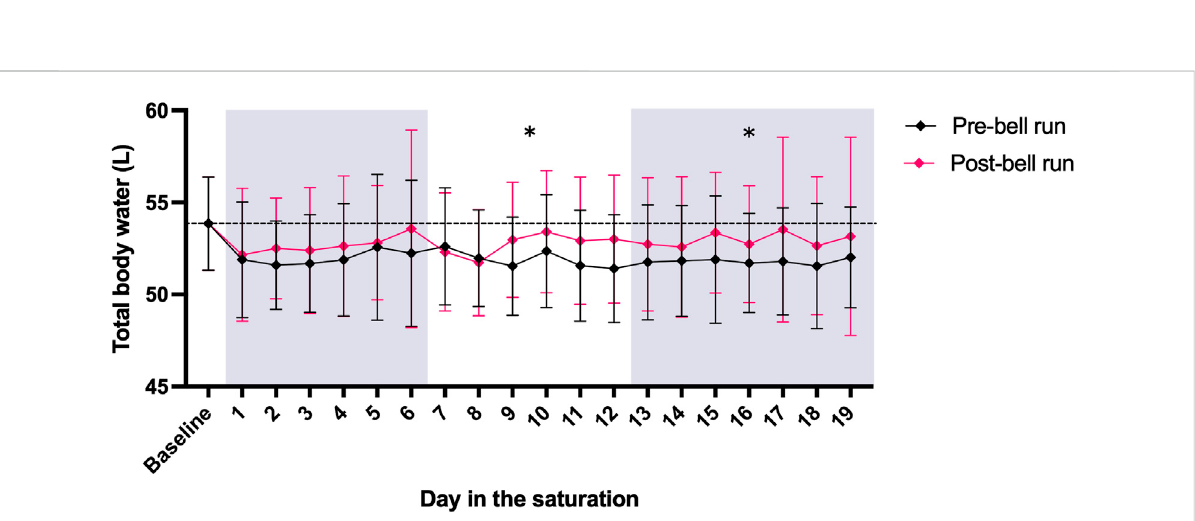
FIGURE 4 TBW calculated from BIA data collected pre- and post-bell runs from 11 saturation divers Diamonds and whiskers are means ± SD. The mean pre-saturation TBW baseline is shown as a horizontal stapled line. Panel shading indicates the three periods for which data were pooled to analyze progressingchangesinTBW. “ * ” indicatesthatthemeanofpre-bellrunTBWfortheperiodwassigni fi cantlybelowthepre-saturationbaseline.There were no differences in post-bell run TBW compared to baseline ( p <